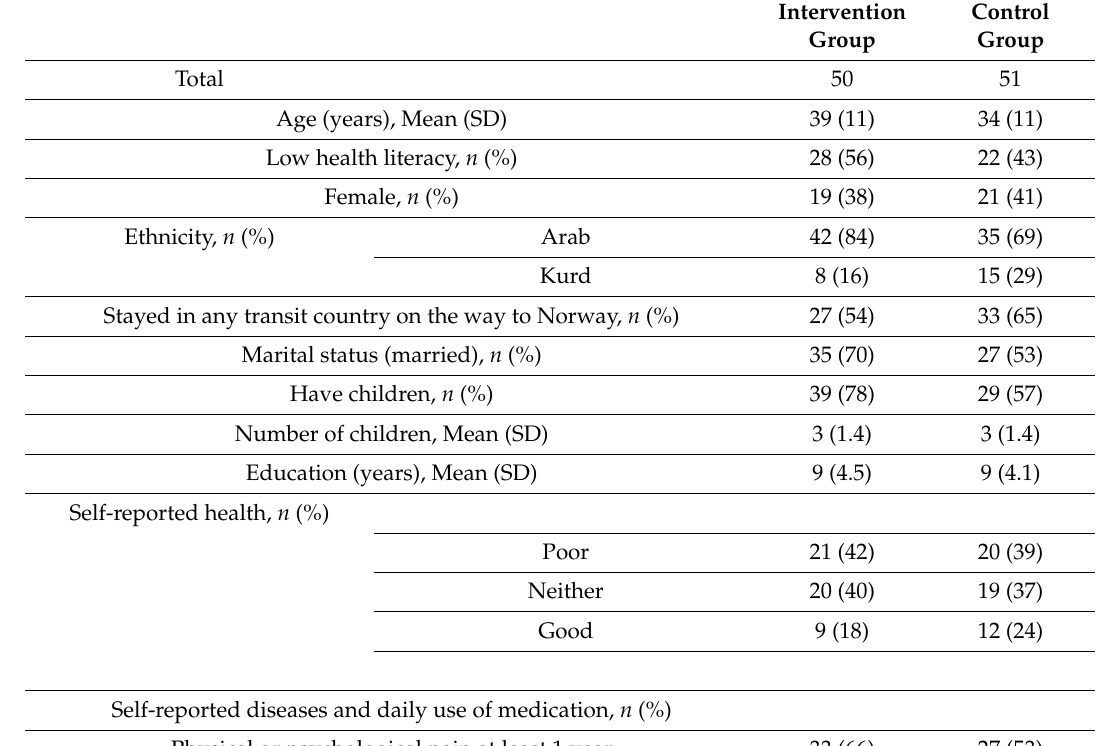
Intervention Control Group